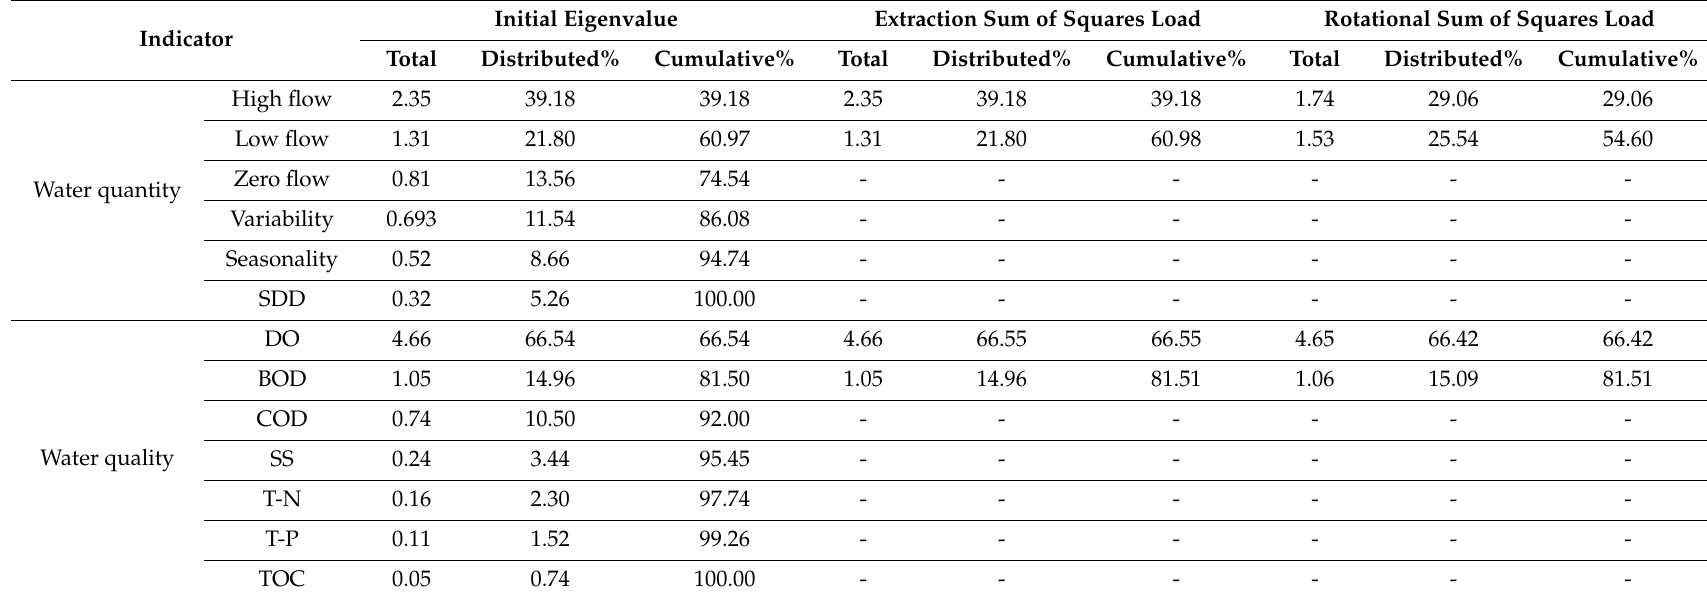
Table 12. The Varimax results for factor